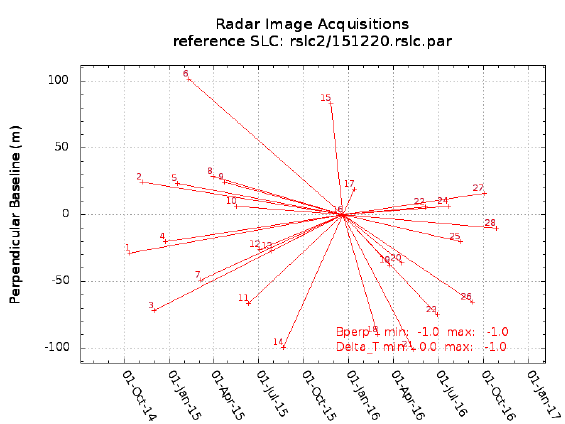
Figure 4. Interferometric pairs in relation to an image December 20, 2015.